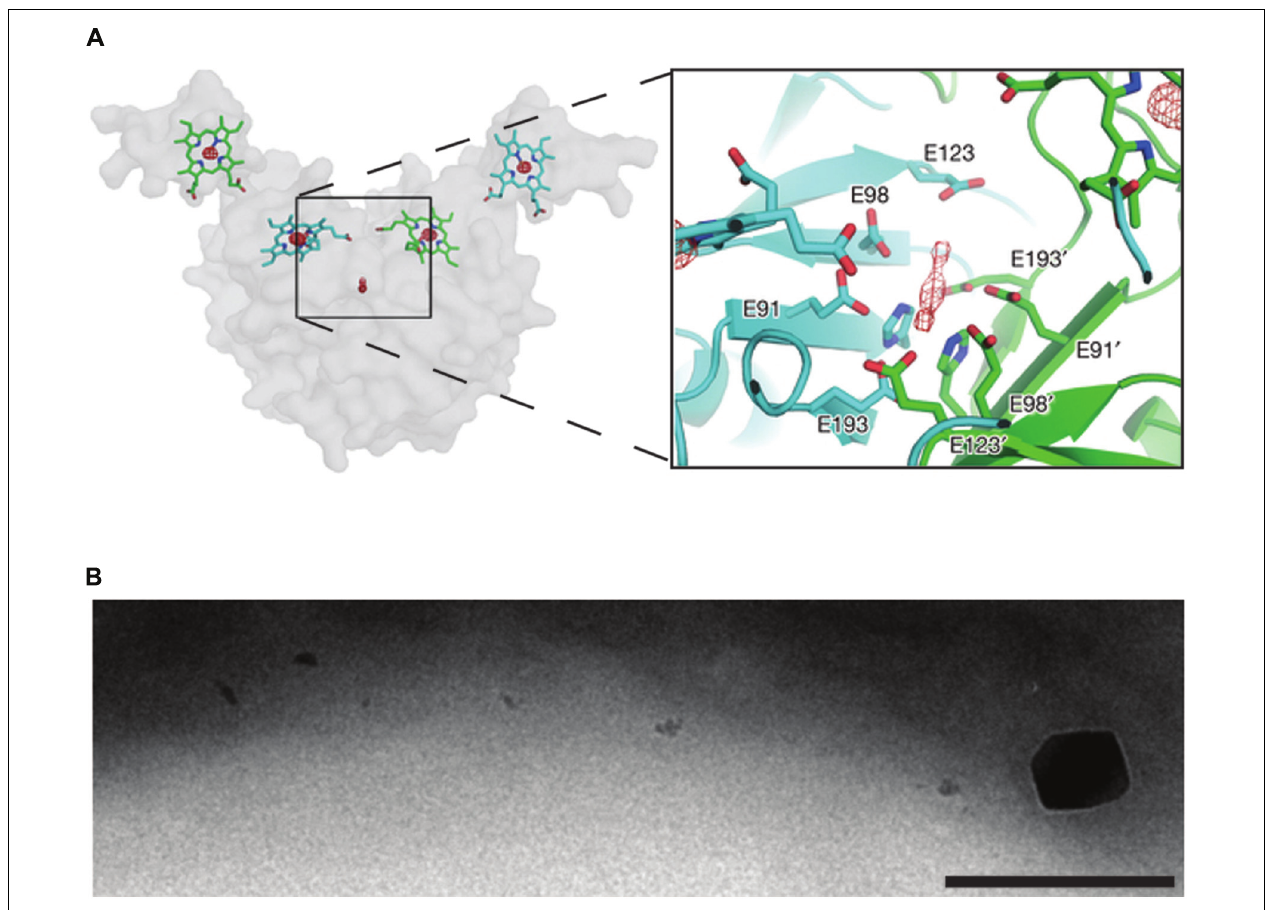
FIGURE 2 | MamP oxidizes iron and regulates magnetite crystal size. (A) , the crystal structure of MO-1 MamP with two atoms of iron bound in the acidic pocket, adapted by permission from Macmillan Publishers Ltd: Nature Siponen etal., 2013, copyright 2013. (B) , a mamP mutant in AMB-1 with many small magnetite crystals and rare large ones. Scale bar 200